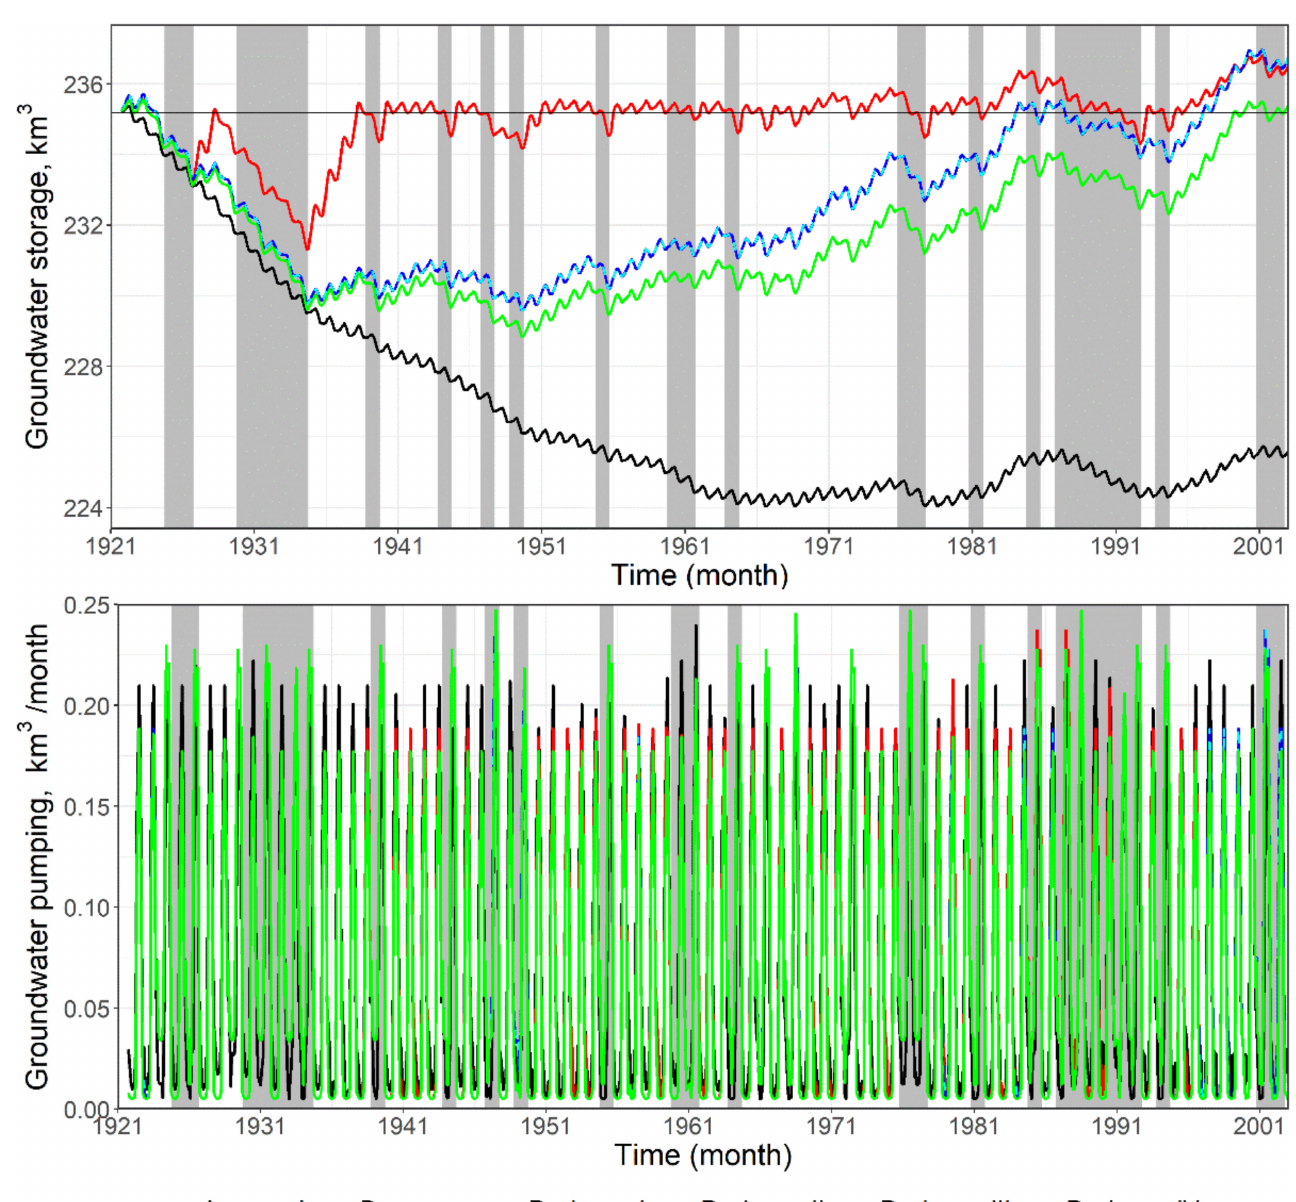
Figure 6. Time series of groundwater storage dynamics ( top ) and groundwater pumping ( bottom ) in three recharge scenarios. Dry years are shaded